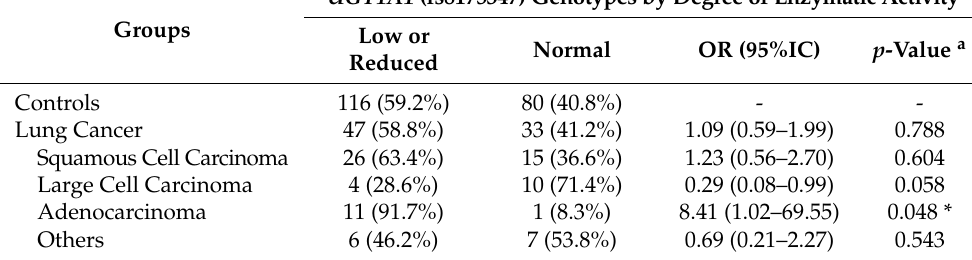
Table 4. Risk for lung cancer and its histological types, associated with degree of UGT1A1 enzy- matic